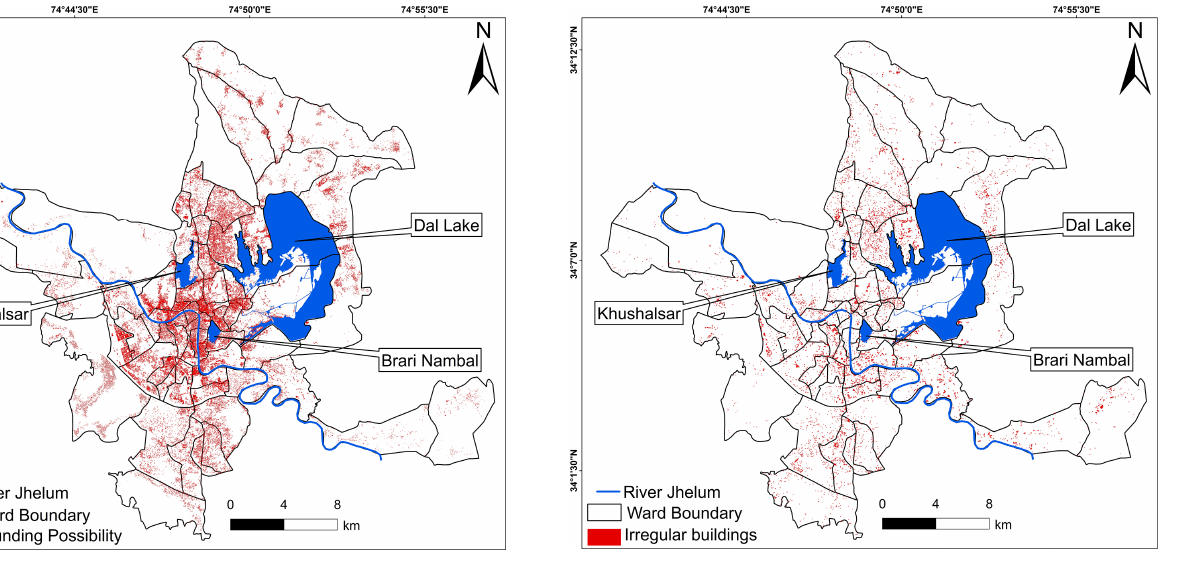
Figure 6. Ward-wise distribution of building pounding possibility in the city.